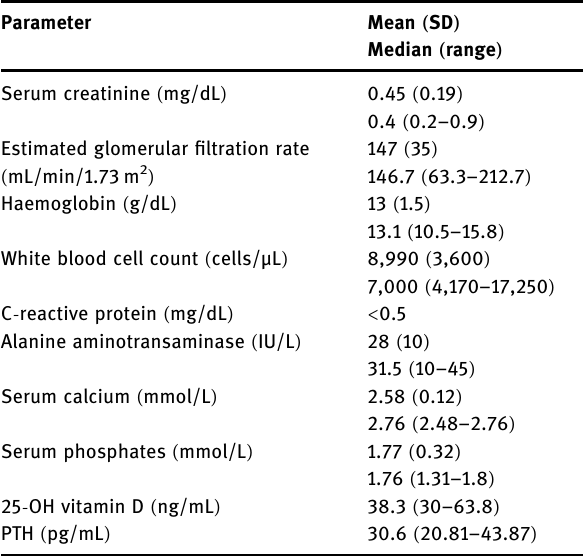
Table 2: Basic biochemical parameters assessed at the enrolment to the